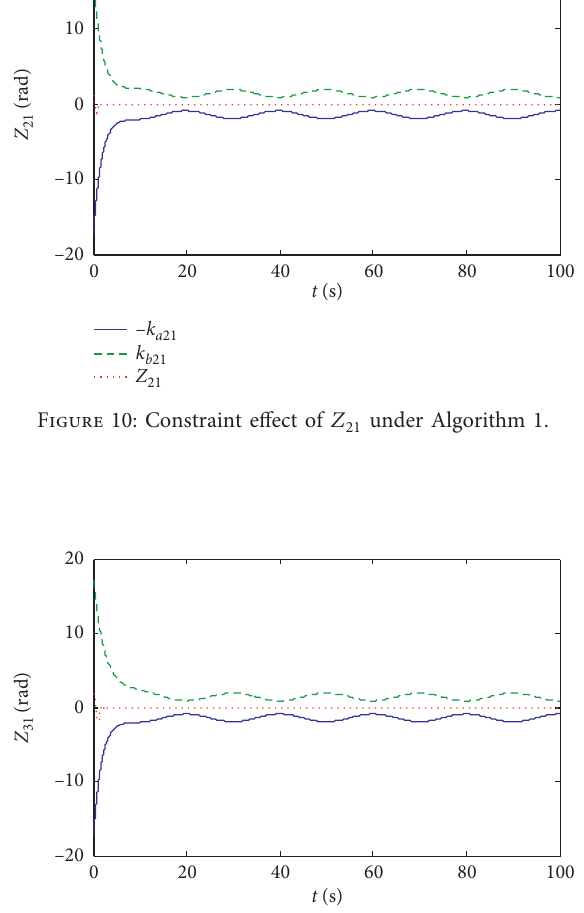
under Algorithm 31